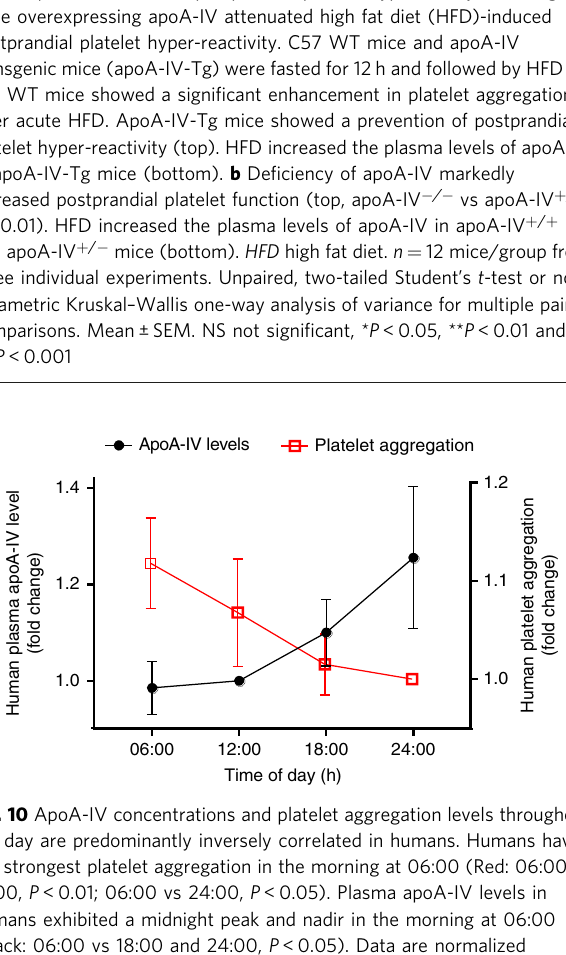
Fig. 10 ApoA-IV concentrations and platelet aggregation levels throughout the day are predominantly inversely correlated in humans. Humans have the strongest platelet aggregation in the morning at 06:00 (Red: 06:00 vs 18:00, P < 0.01; 06:00 vs 24:00, P < 0.05). Plasma apoA-IV levels in humans exhibited a midnight peak and nadir in the morning at 06:00 (Black: 06:00 vs 18:00 and 24:00, P < 0.05). Data are normalized according to platelet aggregation levels at 24:00 and apoA-IV levels